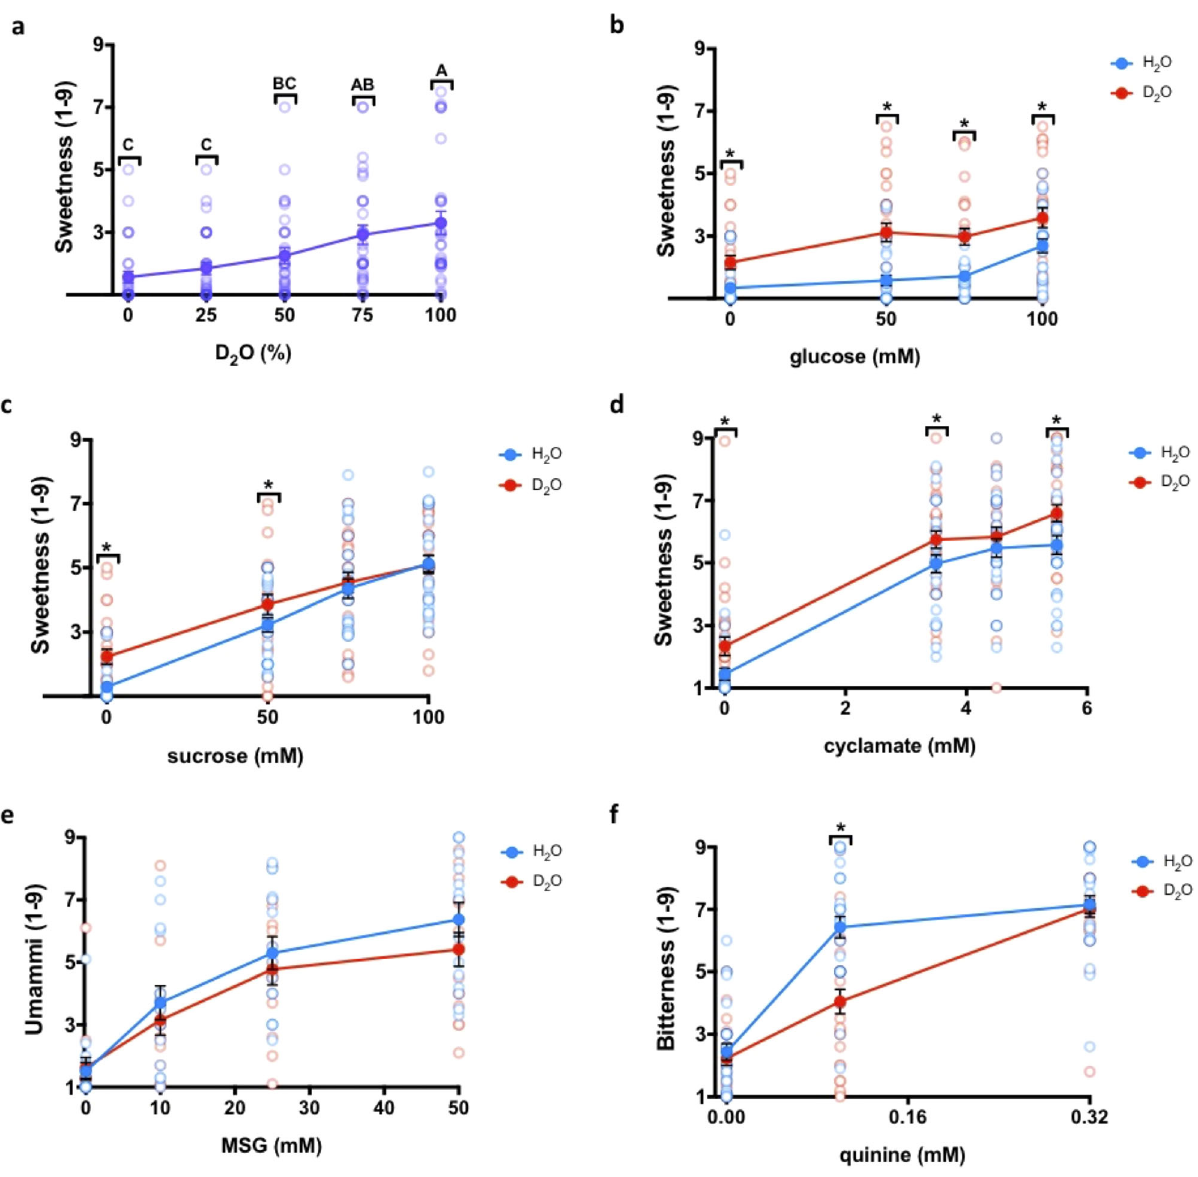
Fig. 2 D 2 O sweetness and its effect on different tastants. a Sweetness of D 2 O mixed at increasing ratios with H 2 O. Treatments not connected by the same letters are signi fi cantly different ( p < 0.05 in Tukey Kramer test). b – f The effect of D 2 O (red) compared to H 2 O (blue) on glucose ( b ), sucrose ( c ), cyclamate ( d ), quinine ( e ), and MSG ( f ) taste-speci fi c intensity. Asterisks indicate a signi fi cant ( p < 0.05) difference between water types using the two- way analysis of variance (ANOVA) with a preplanned comparison t -test. All data are presented as the mean ± the Standard Error of Measurement (SEM); n = 15 – 30 (4 – 12 males). The y axis shows the response for individual modalities, while the x axis is labeled with different water samples. Scale for each modality is labeled as 1 = no sensation, 3 = slight, 5 = moderate, 7 = very much, and 9 = extreme